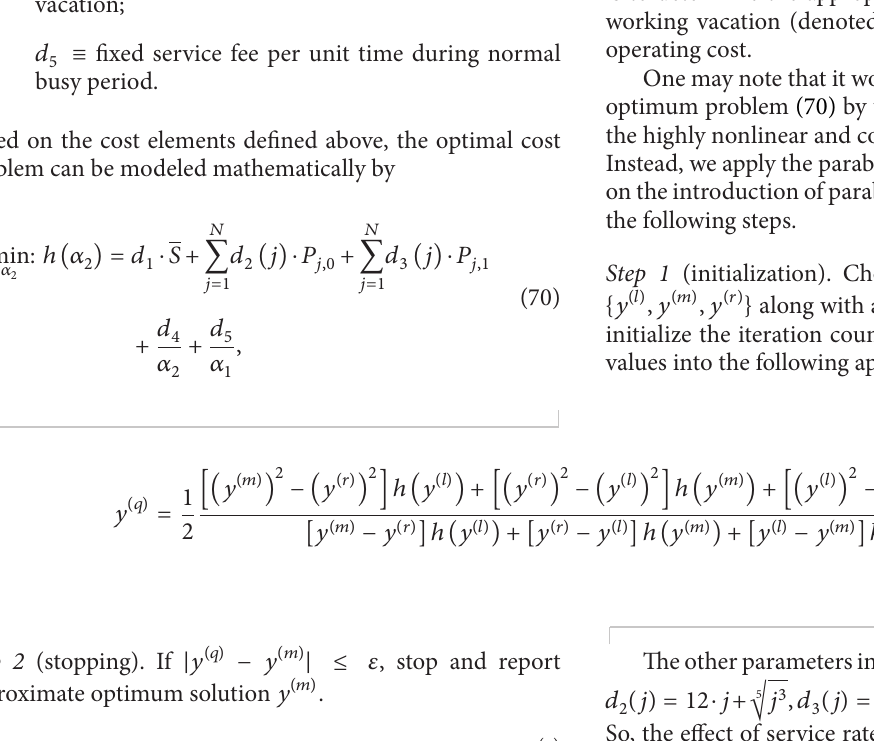
From Figure 5, choosing an initial 3-point pattern ( 1 /𝛼) (𝑙) = 0.05 , ( 1 /𝛼) (𝑚) = 0.1 , ( 1 /𝛼) (𝑟) = 0.15 , and the − 5 , it obtains the optimal value of stopping tolerance 𝜀 = 10 𝛼 𝛼 ∗ = 10 . 5820 which leads to the 2 after three iterations: 2 minimum expected operating fee: ℎ(𝛼 ∗ 2 ) = 2849 .